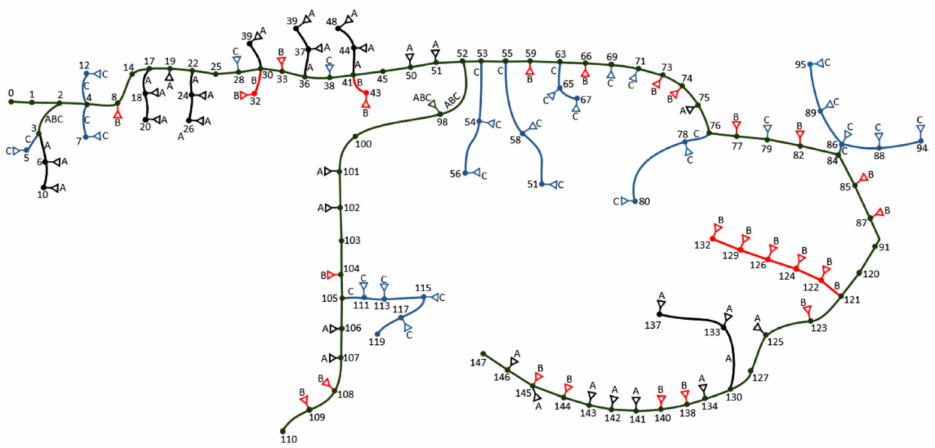
Figure 2. Real-life 186-bus feeder.